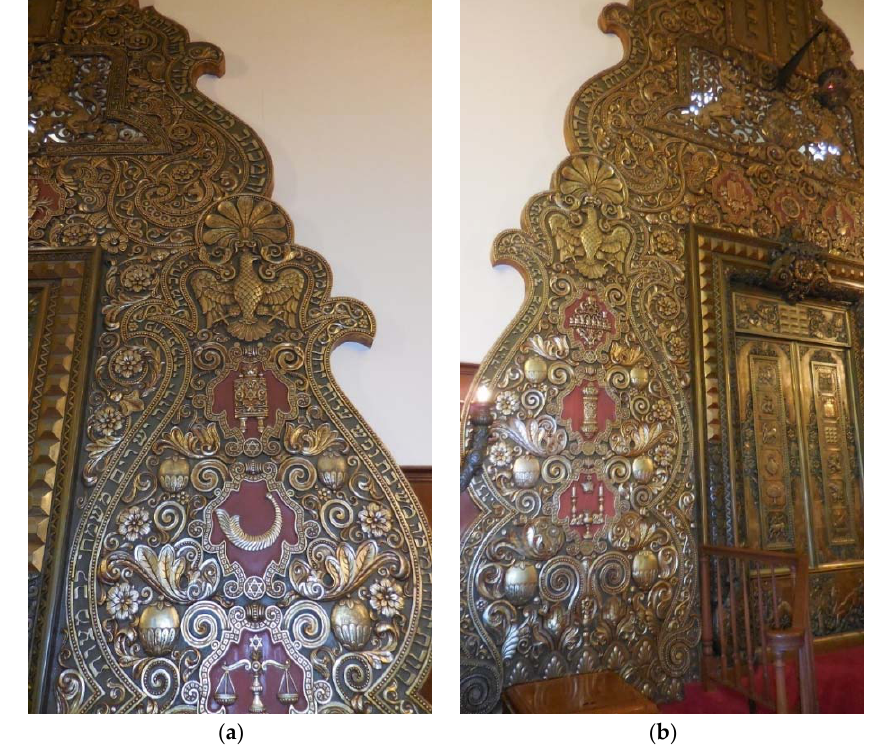
Figure 9. The right ( a ) and left ( b ) sides of the ark.